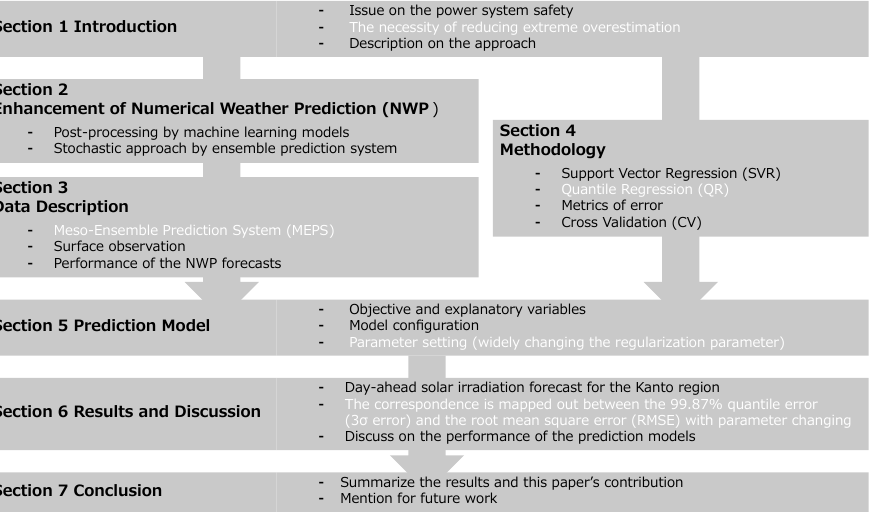
Figure 2. Summary of this paper. The white text indicates the parts that are closely related to our work for reducing extreme